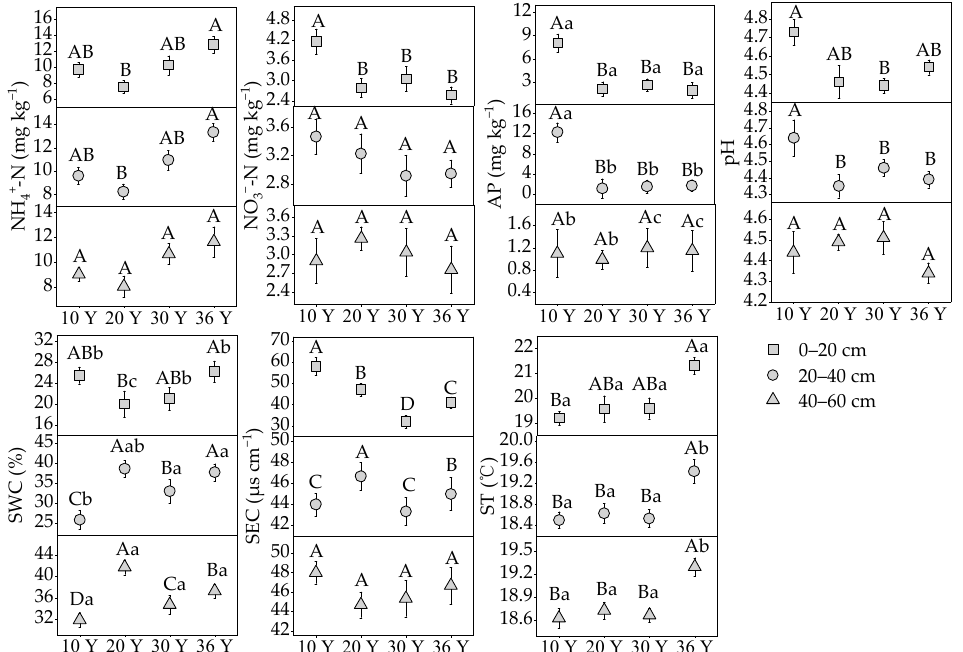
Figure 3. Soil physicochemical properties of different ages and soil depths. NH 4+ -N: ammonium nitrogen; NO 3– -N: nitrate nitrogen; AP: available phosphorus; SWC: soil water content; SEC: soil electrical conductivity; ST: soil temperature. 10 Y: 10-year stand; 20 Y: 20-year stand; 30 Y: 30-year stand; 36 Y: 36-year stand; 0–20 cm: 0–20 cm soil depth; 20–40 cm: 20–40 cm soil depth; 40–60 cm: 40–60 cm soil depth. The values show means ± SE. Different capital and lowercase letters represent differences among different stand ages and soil depths, respectively ( p < 0.05). Table 2. Effects of stand age (A), soil depth (D), and their interactions on soil physicochemical properties, enzyme activities, and the microbial diversity indicated by a two-way repeated measures ANOVA.